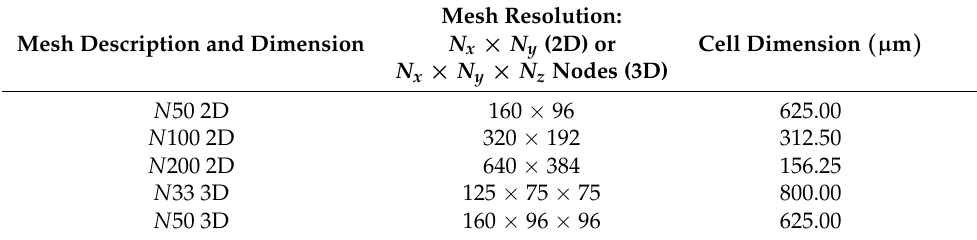
Table 2. Mesh resolutions for different